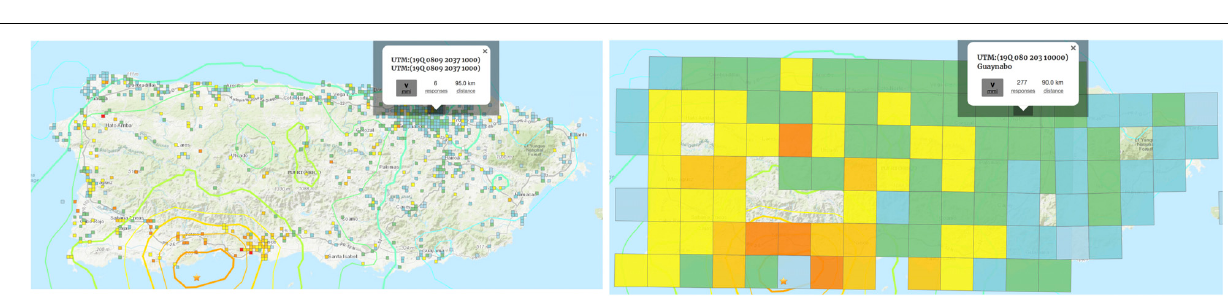
FIGURE 5 | Comparison of 1-km (left) and 10-km (right) UTM blocks for the M6.4 Indios, Puerto Rico earthquake. Both maps are the same scale. Intensity, number of responses, and distance from the UTM area centroid to the epicenter are shown for representative areas in each map. Blocks are color-coded to the intensity scale shown in Figure 1 (Source: U.S. Geological